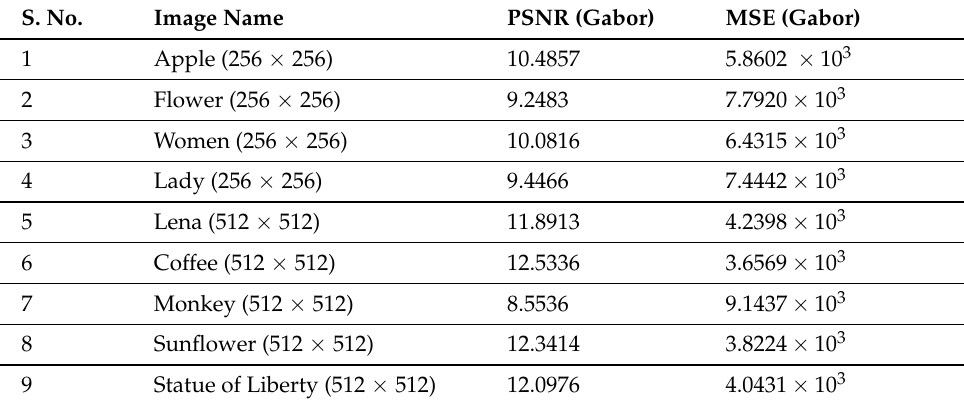
Table 1. Results of PSNR and MSE values for different image datasets applied with the Gabor filter-based edge